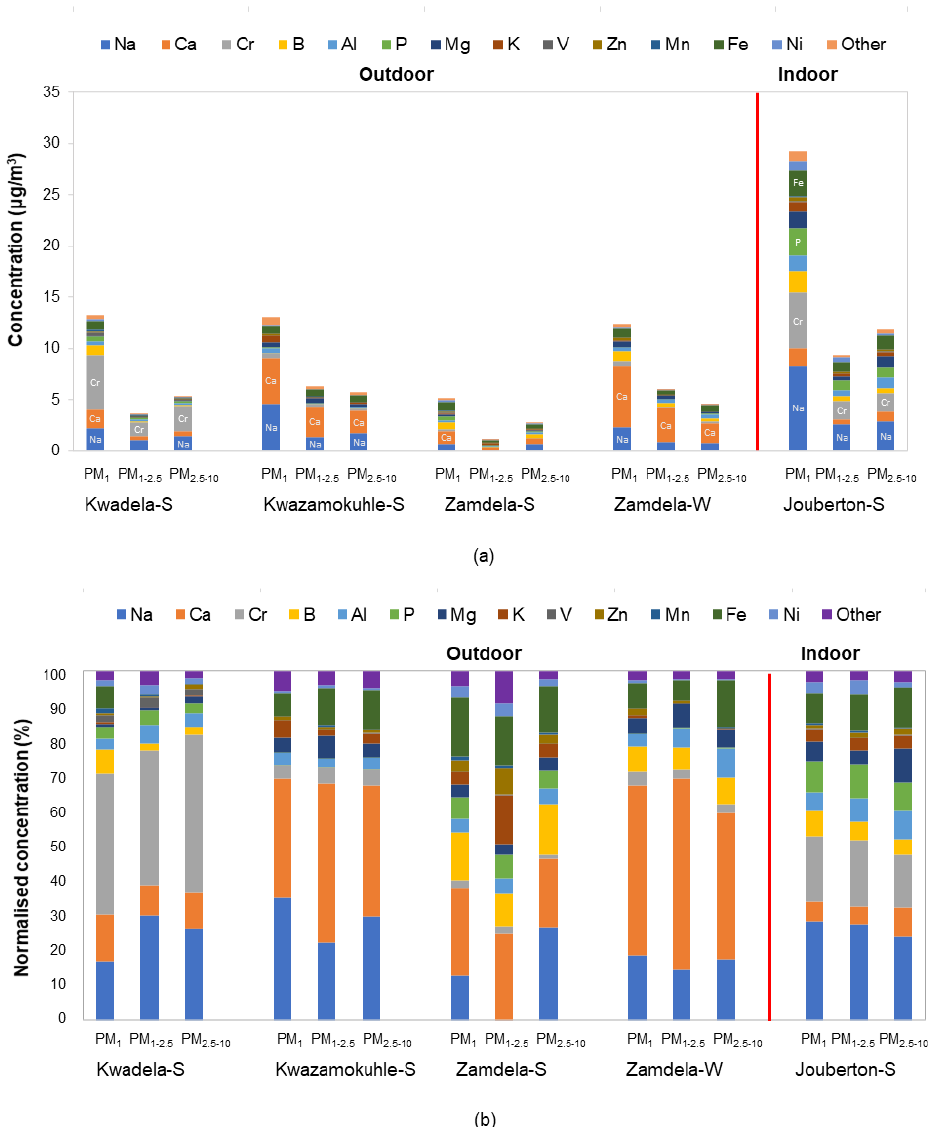
Figure 6. (a) Mean trace element concentrations and (b) normalised concentration distributions of individual trace element species deter- mined in PM 1 , PM 1 − 2 . 5 , and PM 2 . 5 − 10 at each site during respective sampling